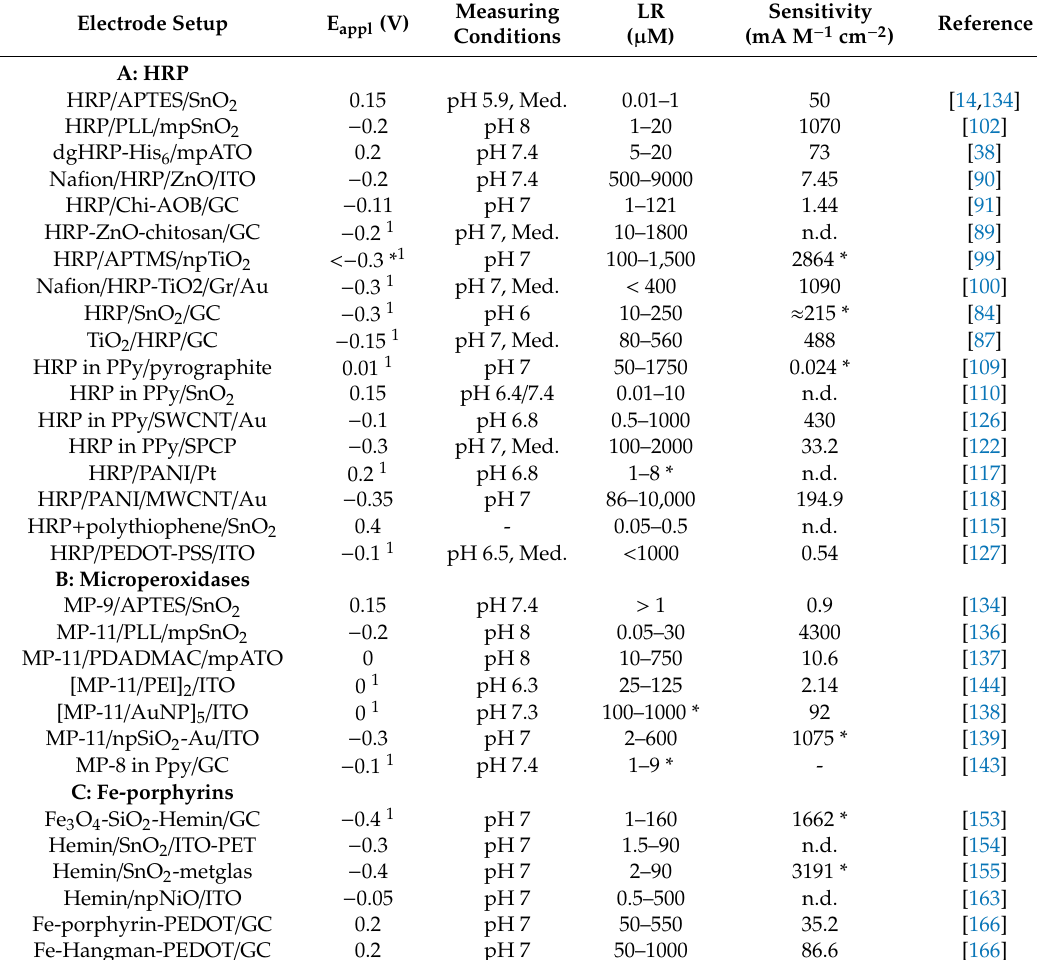
Figure 8. Hydrogen peroxide sensor based on electropolymerized Fe-porphyrins operating at moderate potentialsinaqueoussolution. ( a )Schematicillustrationofaco-polymerfilmofthienylatedFe-Hangman porphyrin and poly(ethylenedioxythiophene) (PEDOT) deposited on glassy carbon. ( b ) Linear sweep voltammograms of the porphyrin / PEDOT films before and after addition of 5 mM hydrogen peroxide at a scan rate of 2 mV / s. ( c ) Amperometric response of the porphyrin / PEDOT films to increasing hydrogen peroxide concentrations at 0.2 V vs. Ag / AgCl. Measurements were performed in 100 mM phosphate bu ff er, pH 7, at a stirring speed of 300 rpm. Table 1. Performance of selected sensors for hydrogen peroxide based on natural peroxidases or peroxidase mimics immobilized on